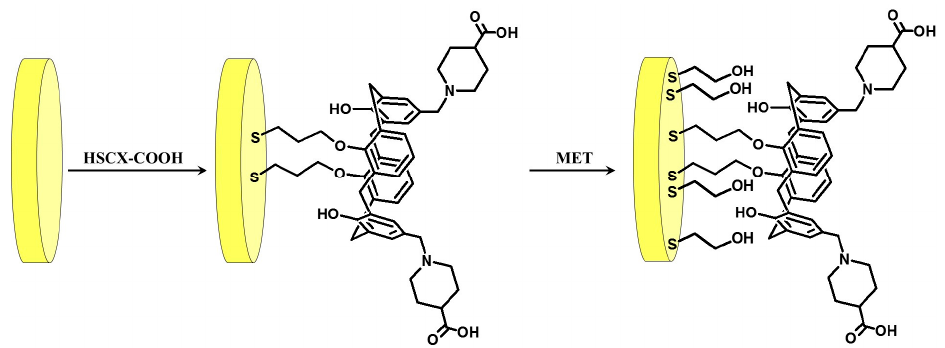
Figure 1. Schematic illustration of the 5,17-bis[ N -(4-carboxypiperidino)methyl]-25,27-bis(3-mercaptopropoxy)-26,28-dihydroxycalix[4]arene (HSCX-COOH)/ 2-mercaptoethanol (MET) layer preparation.